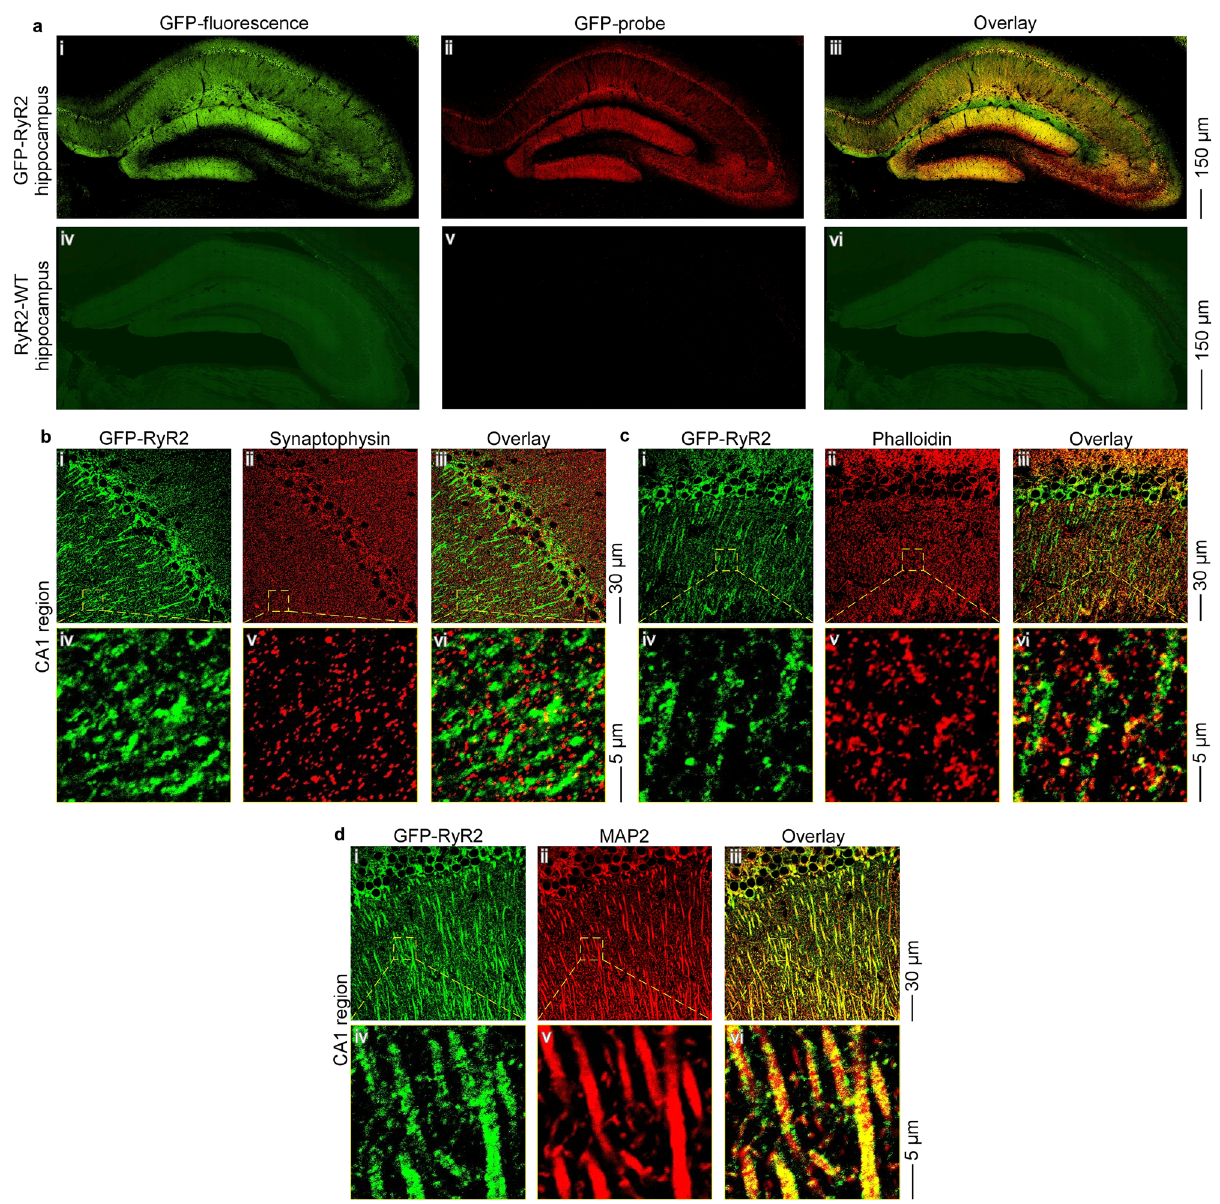
Fig. 1 Co-localization of GFP-RyR2 with synaptic markers in hippocampal CA1 region in fi xed brain slices using confocal imaging. a Representative confocal fl uorescence images of hippocampus in fi xed brain slices from mice expressing the GFP-tagged RyR2 (ai – iii) and non-GFP RyR2-WT mice (aiv – vi) ( n = 16 images from eight brains for each group) with GFP- fl uorescence (ai, iv), GFP-probe staining (aii, v), and overlay between the GFP and GFP-probe signals (aiii, vi) depicted. Representative confocal fl uorescence images of hippocampal CA1 region in fi xed brain slices from mice expressing a GFP-tagged RyR2 that were co-stained with the GFP-probe (displayed in green) and the presynaptic major vesicle protein synaptophysin ( b ), the F-actin targeting phalloidin ( c ), or the microtubule-associated protein 2 (MAP2) ( d ) ( n = 30 images from eight brains). GFP-probe staining (i, iv), synaptic marker staining (ii, v), and overlay between the GFP-probe and synaptic marker signals (iii, vi) are terminals or the dendritic spines of hippocampal CA1 pyramidal hippocampal CA1 (Supplementary Fig. 5) and DG (Supplemen- or DG granular neurons. tary Fig. 6) regions with staining patterns similar to those observed using confocal imaging. There was a minimal/partial overlap between the GFP probe signal and synaptophysin or phalloidin staining in hippocampal CA1 (Supplementary Subcellular localization of RyR2 in hippocampal neurons using Fig. 5ai – iii, v – vii) or DG (Supplementary Fig. 6ai – iii, v – vii) structured illumination microscopy (SIM) imaging of fi xed regions. In contrast, there was an extensive overlap of the GFP brain slices . To further de fi ne the subcellular distribution of probe signal and MAP2 staining in hippocampal CA1 (Supple- RyR2, we carried out co-localization studies of GFP-RyR2 with mentary Fig. 5aix – xi) and DG (Supplementary Fig. 6aix – xi) well-established neuronal markers in fi xed brain slices using regions. Quantitative analysis of color overlap in SIM images structured illumination microscopy (SIM) imaging. As shown in showed that there was ~50% overlap between the GFP probe and Supplementary Figs. 5 and 6, SIM imaging revealed fi ne details of MAP2 signals, whereas, there was <5% overlap between the GFP synaptophysin, phalloidin, MAP2, and GFP-probe staining in